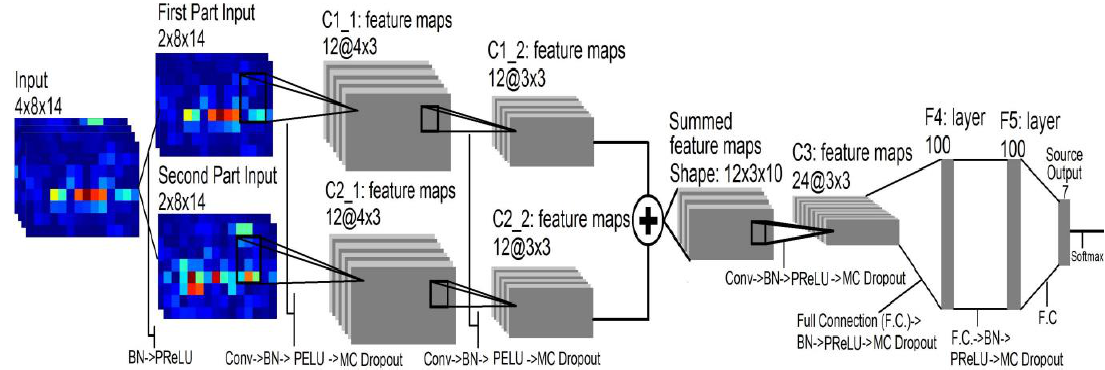
Figure 3. Schematic diagram of ConvNet architecture. In this figure, Conv refer to Convolution and F.C. to Fully Connected layers.